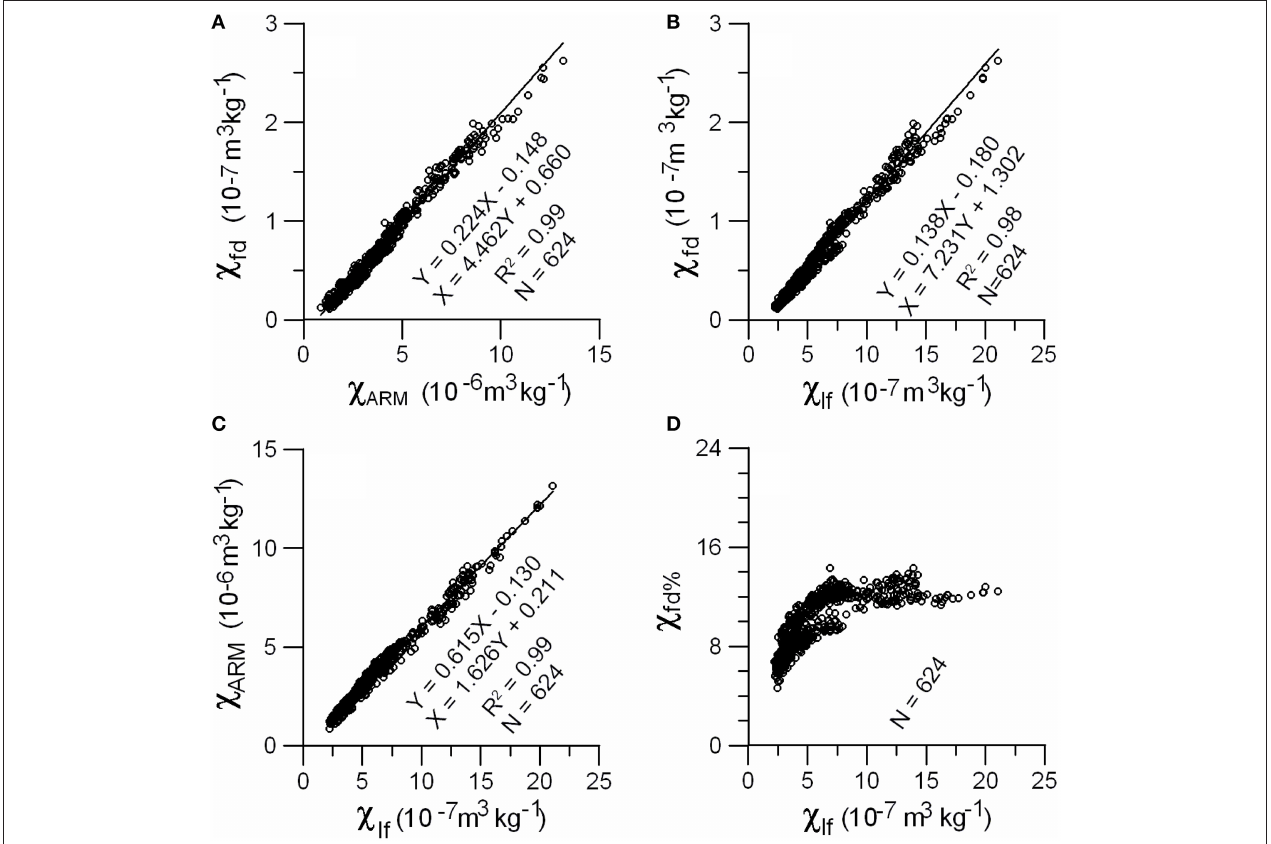
FIGURE 4 | The relationship (Nie et al., 2007) between χ ARM vs. χ fd (A), χ lf vs. χ fd (B), χ lf vs. χ ARM (C), and χ fd vs. χ fd % (D) in the red-clay sequence from Chaona. Modified from Nie et al.